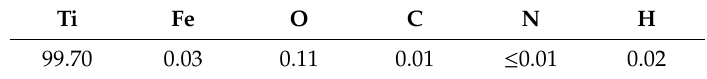
Table 1. Chemical composition of pure titanium Grade II powder used in